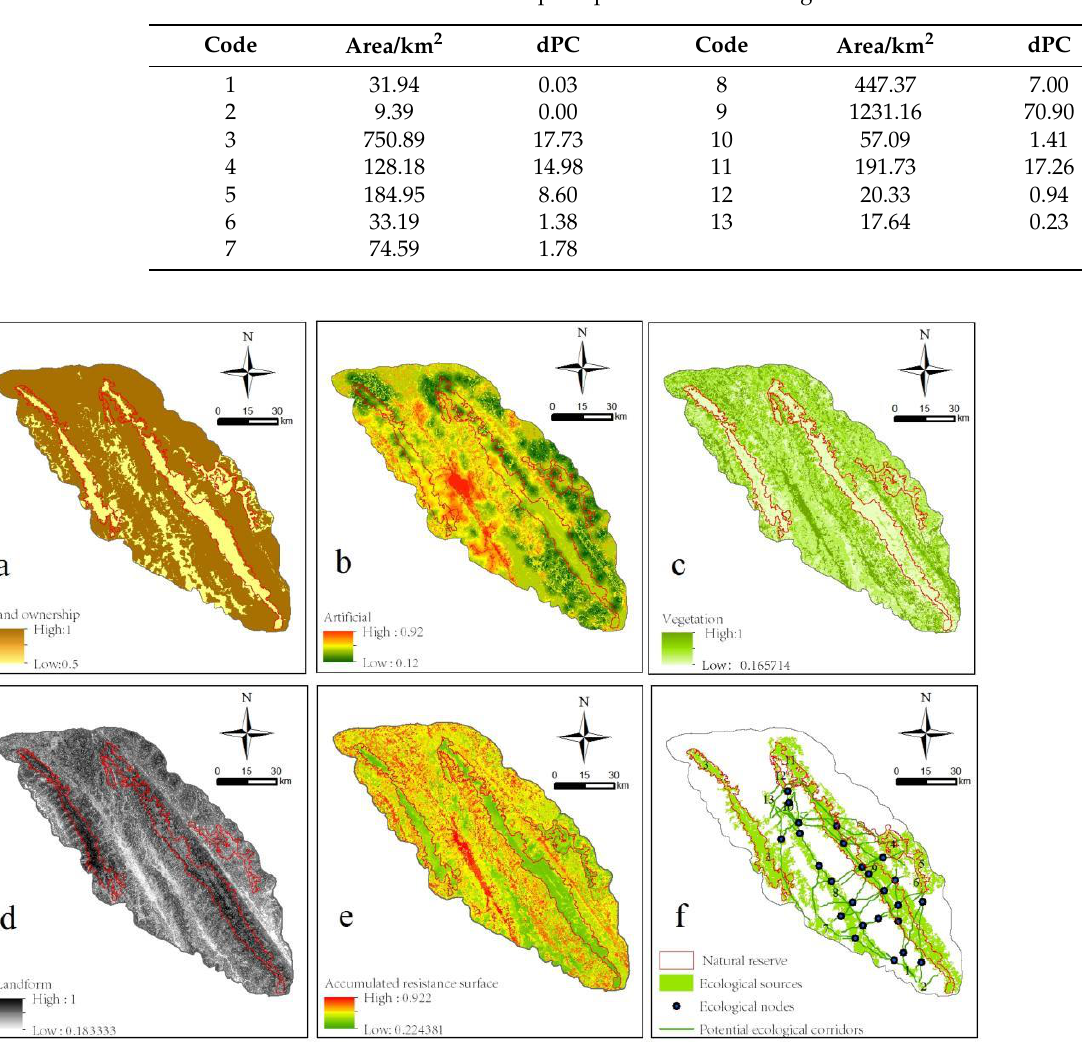
Figure 4. Ecological network of the national park.